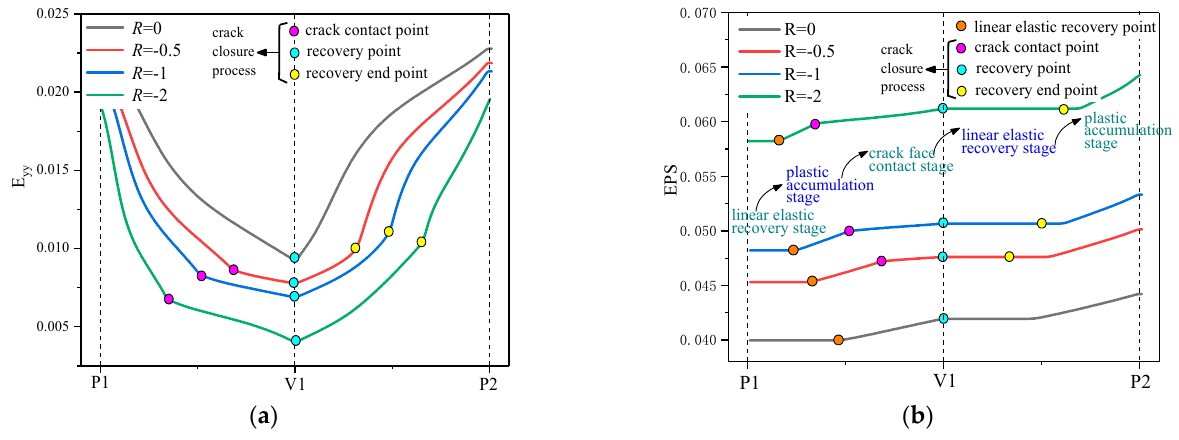
Figure 9. Effect of loading ratio on strain field ： ( a ) E yy with loading history for K3-N, ( b ) EPS with loading history for K3-N.